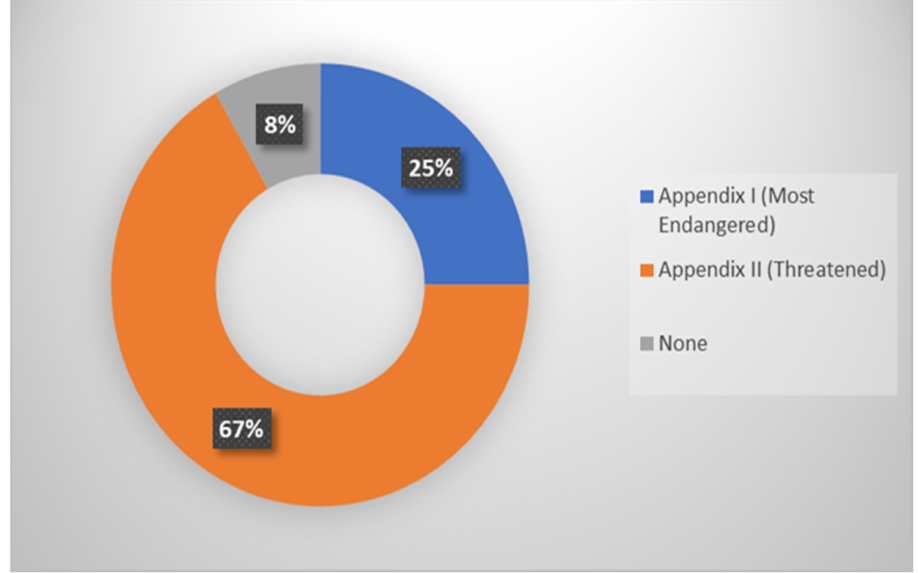
Figure 4. Chart of CITES’s appendices on